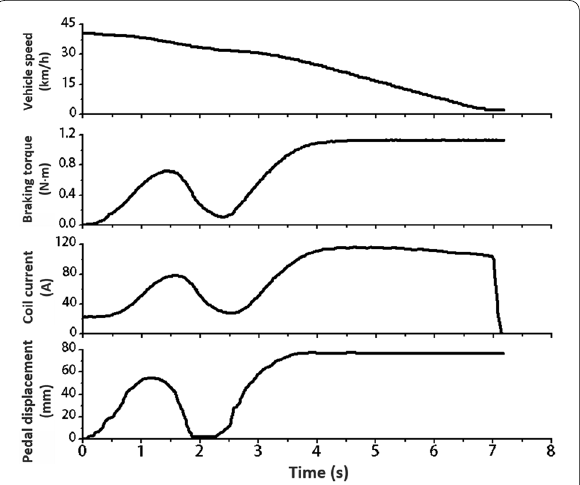
Figure 17 Braking parameter variations in the AMRBTB while stepping on the brake